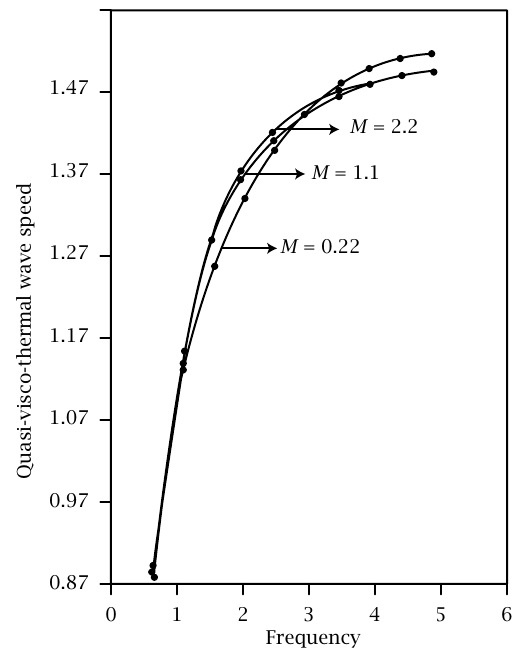
Figure 7.3 . Plot of quasi-visco-thermal wave speed against real frequency ω